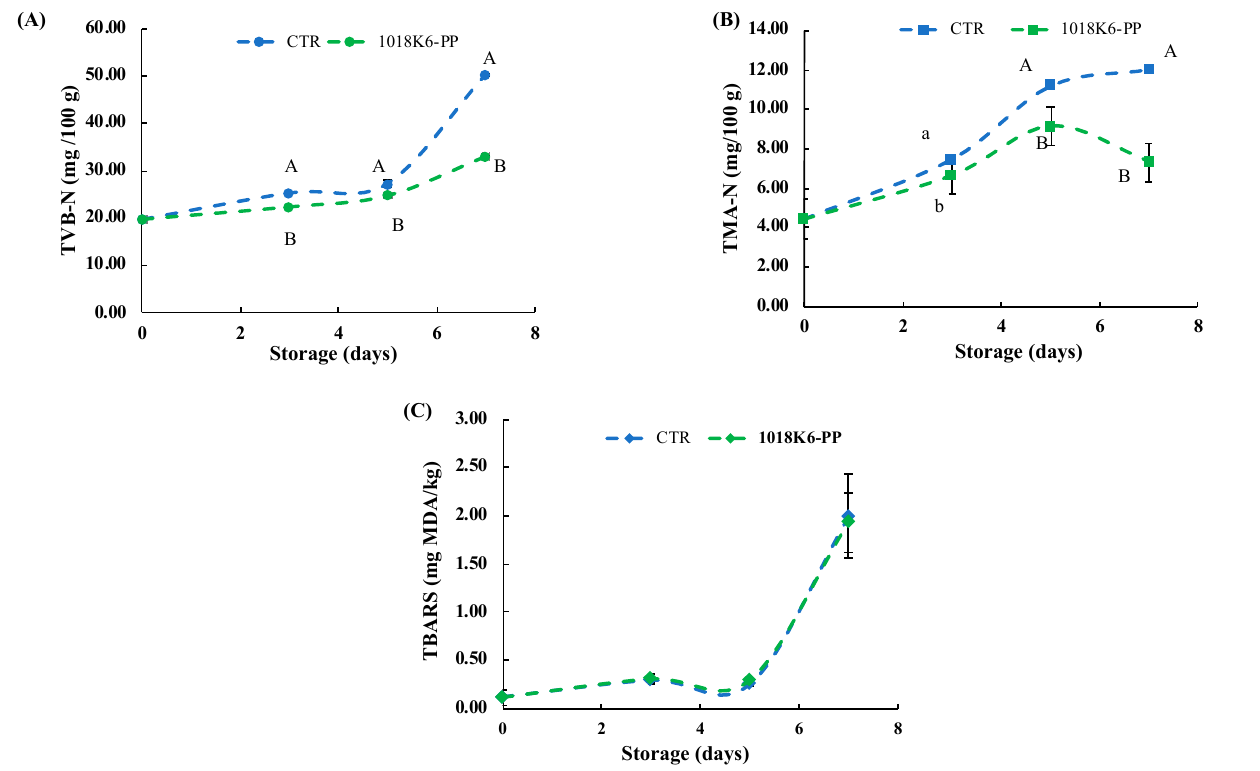
Figure 8. Effects of 1018K6-PP slides on the chemical quality of Sarda sarda burgers. Changes in TVB-N ( A ), TMA-N ( B ) and TBARS ( C ) of Sarda sarda burgers packaged in active 1018K6-PP films during storage at 4 ◦ C. CTR (blue lines)—PP films without 1018K6; 1018K6-PP (green lines)—PP films functionalized with 1018K6. Results are means of three independent experiments and error bars represent the standard error (sem). Different letters at each sampling time are used for significantly different samples, according to Tukey test (uppercase letters: p < 0.01; lowercase letters: p < 0.05).